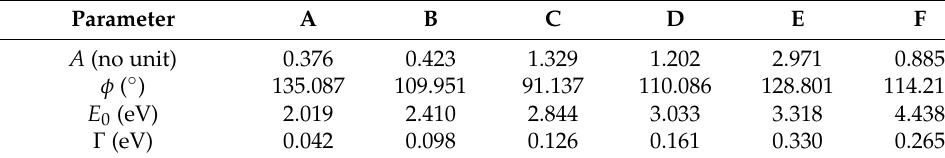
Table 2. Best-fitting parameters of the CPs analysis for the monolayer WS 2 .